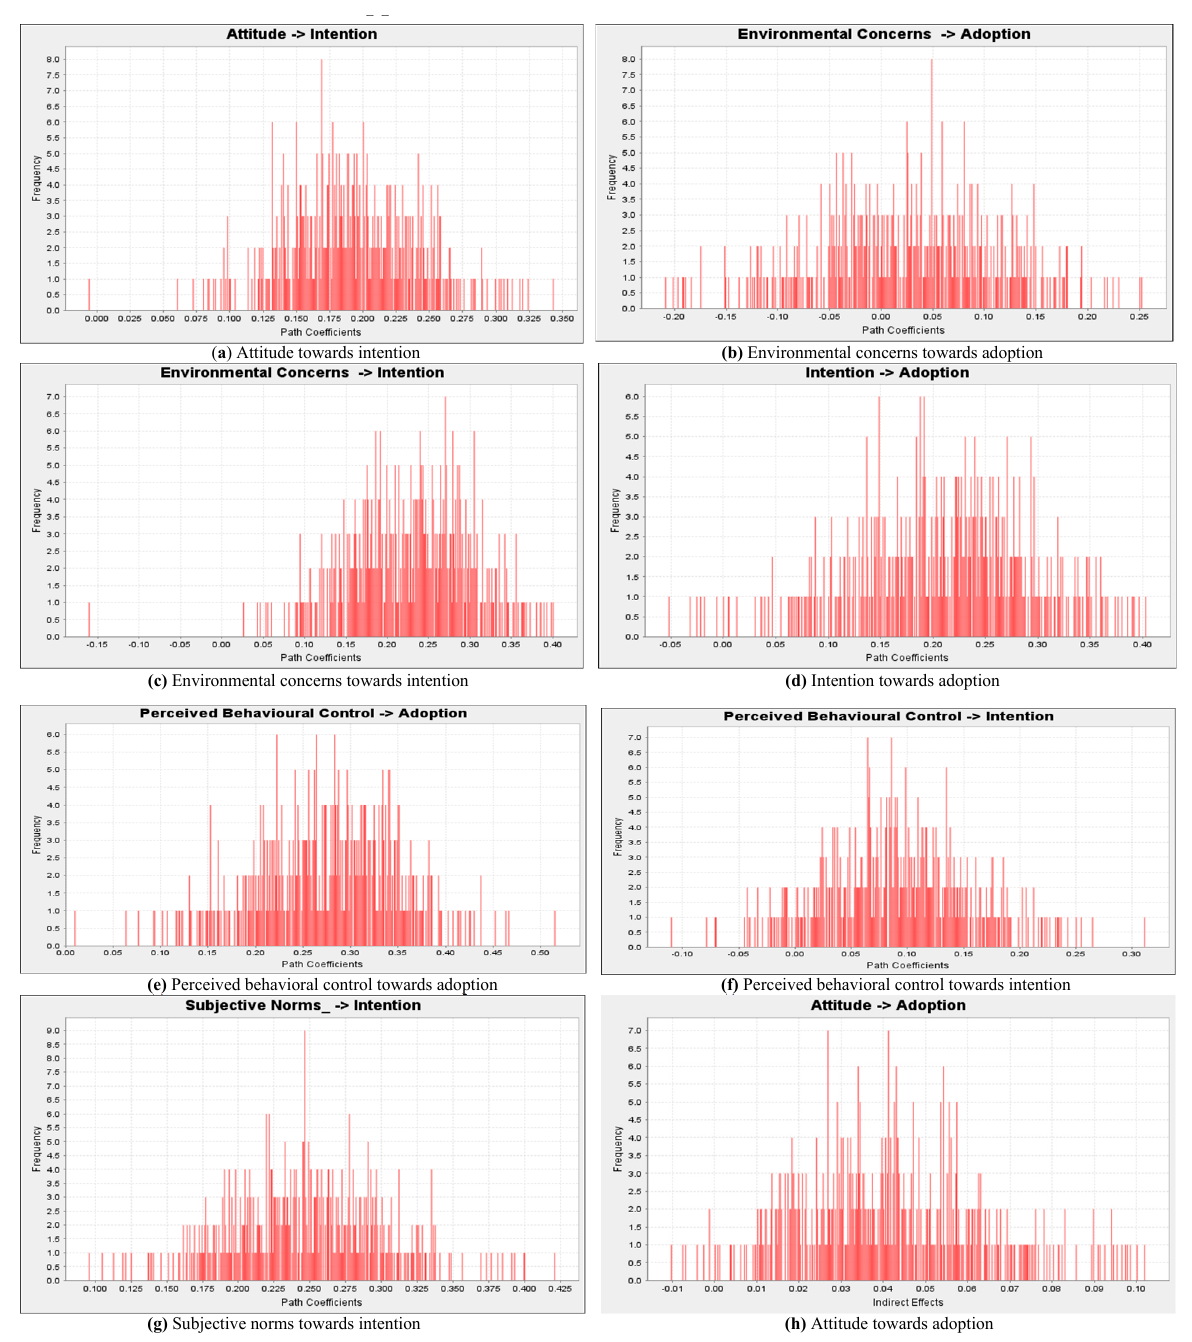
Figure A1. Histograms of a path coefficient.